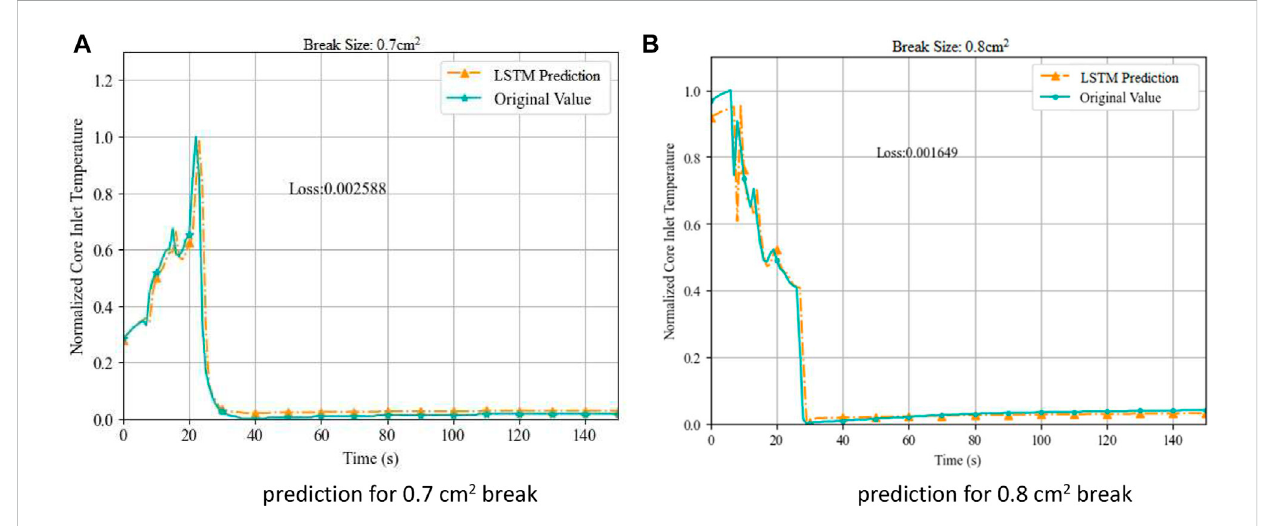
FIGURE 4 Prediction of core inlet temperature during LOCA. (A) prediction for 0.7 cm 2 break (B) prediction for 0.8 cm 2